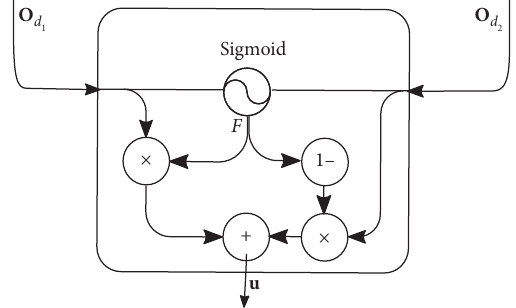
Figure 3: Detailed fusion gate in DANN